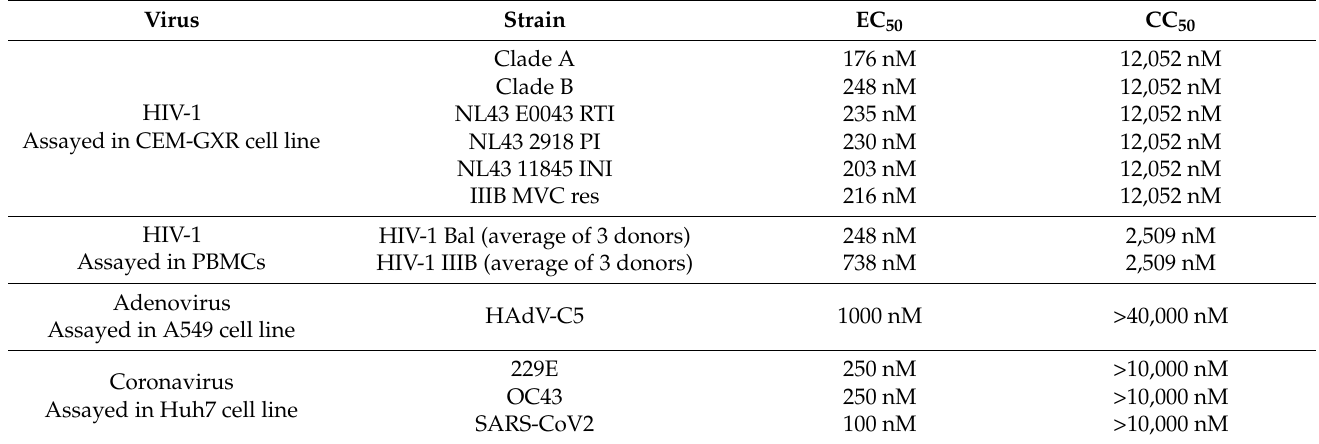
Table 1. Effect of GPS491 on replication of multiple mammalian